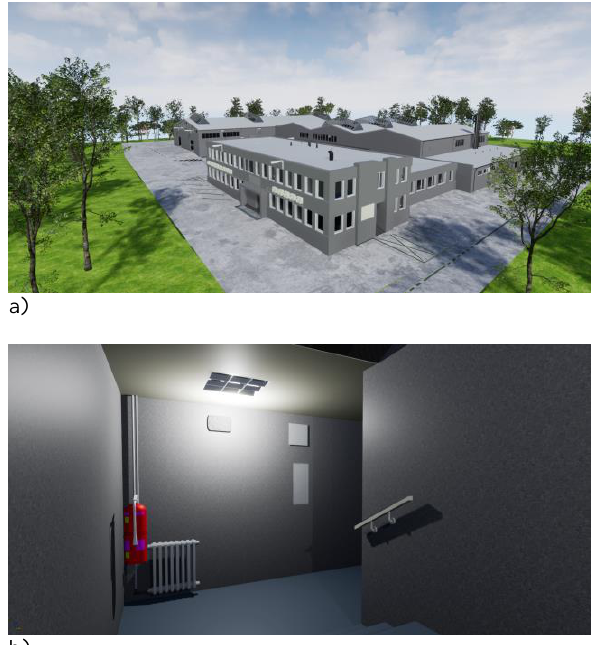
Figure 10 a ,b. Measuring and object modelling based on laser scanned data; an office building and